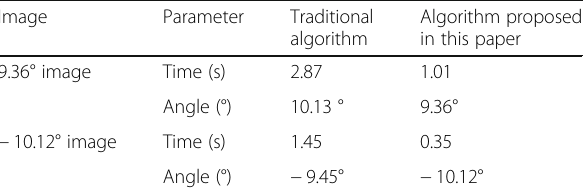
Algorithm proposed algorithm in this